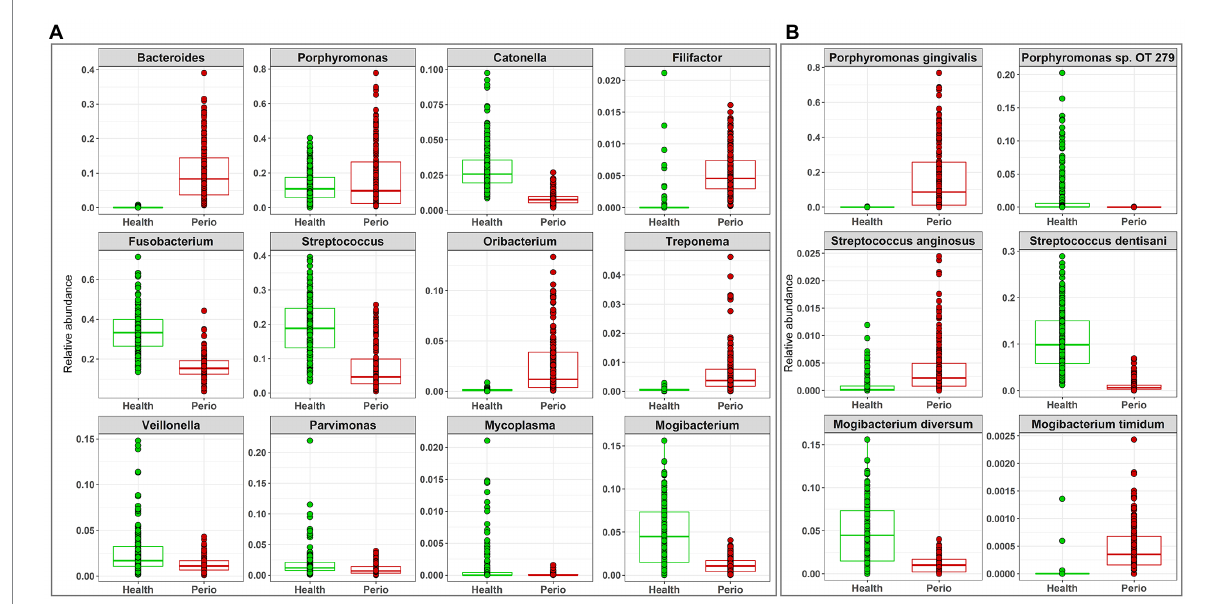
FIGURE 3 Selected differentially abundant taxa in the periodontitis and health-derived microbiomes. Centered log-ratio (CLR) transformed data were analyzed with MaAsLin2 including health status, biological replicate, medium, shaking, and incubation time as fixed effects and technical replicates as random effects. Relative abundances are shown for (A) 12 genera and (B) 3 pairs of “sister” species that significantly differed (FDR value < 0.1) between the two groups. Plots were produced with